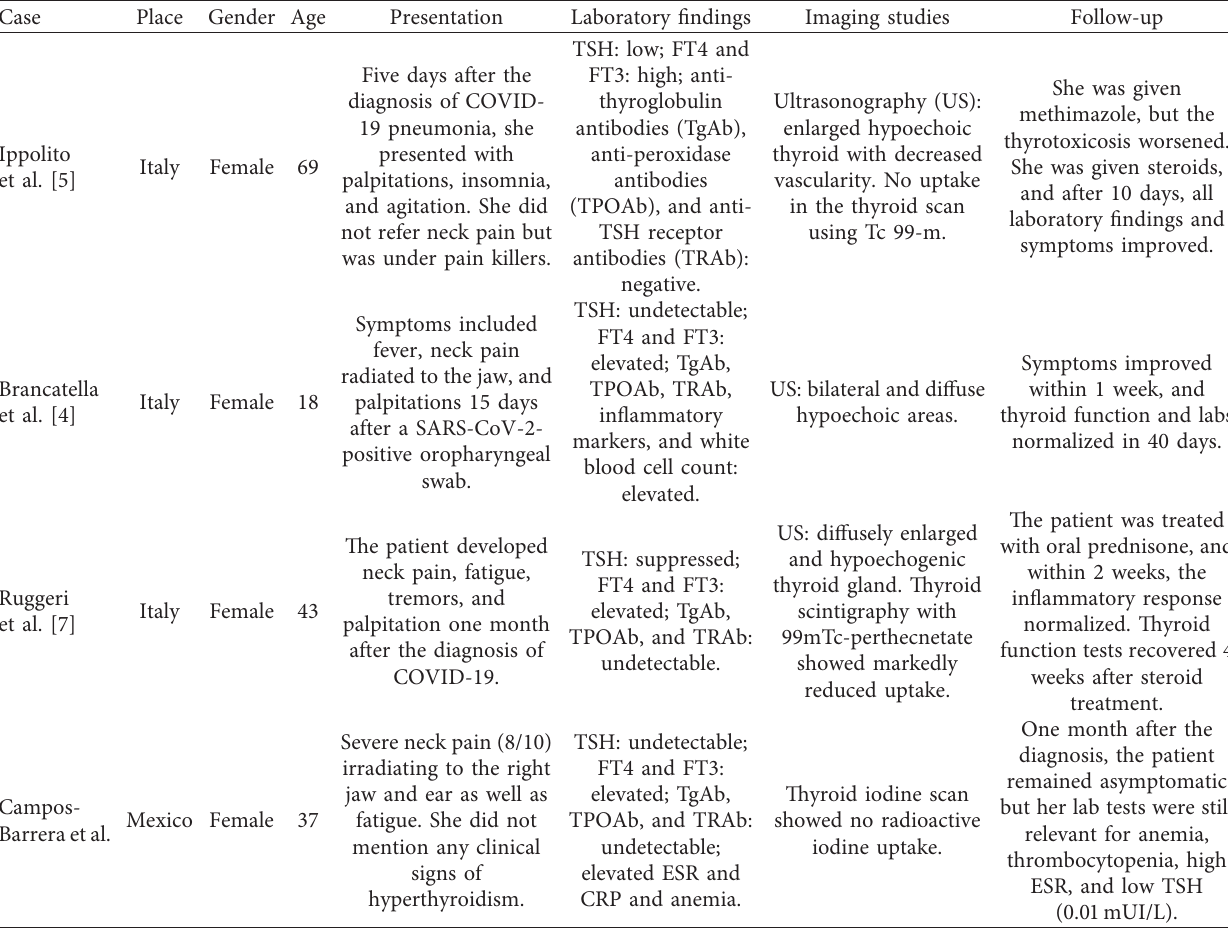
Table 1: Available case reports on SAT associated with